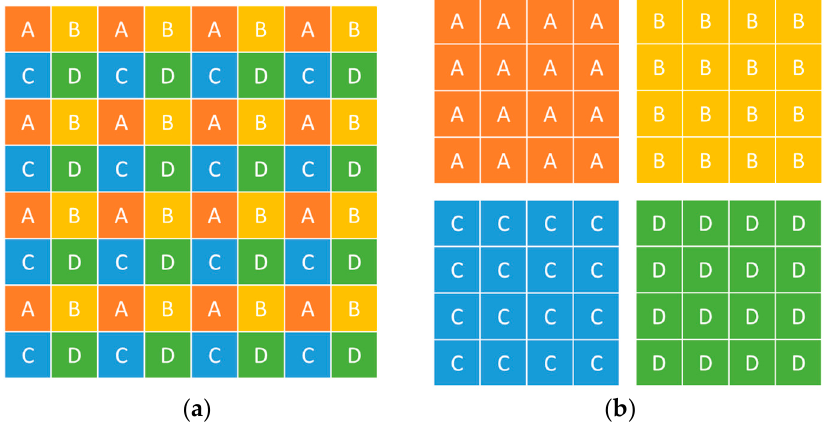
Figure 5. Graphic of a downsampling model. ( a ) Original image; ( b ) four downsampled LR images.